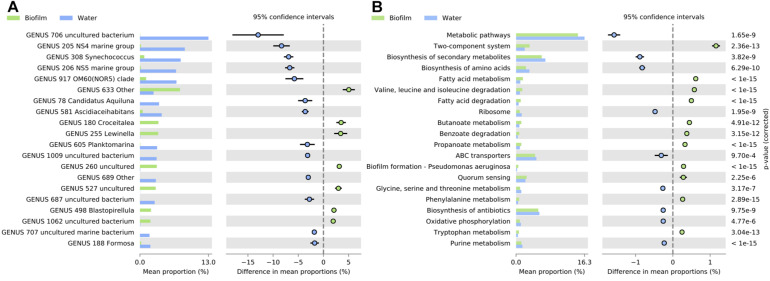
Bar graph representing relative proportions of significant genera (A) and KEGG Pathways at level 3 of SEED metabolic hierarchy (B) in biofilms (green) and seawater (blue) samples. Extended error bar plots showed pairwise comparison of significant genera (A) and KEGG Pathways at level 3 of SEED metabolic hierarchy (B) proportions (Welch’s t-test; p < 0.01) between in biofilms (green) and seawater (blue) samples. Corrected p-value is determined using Fisher’s exact test.